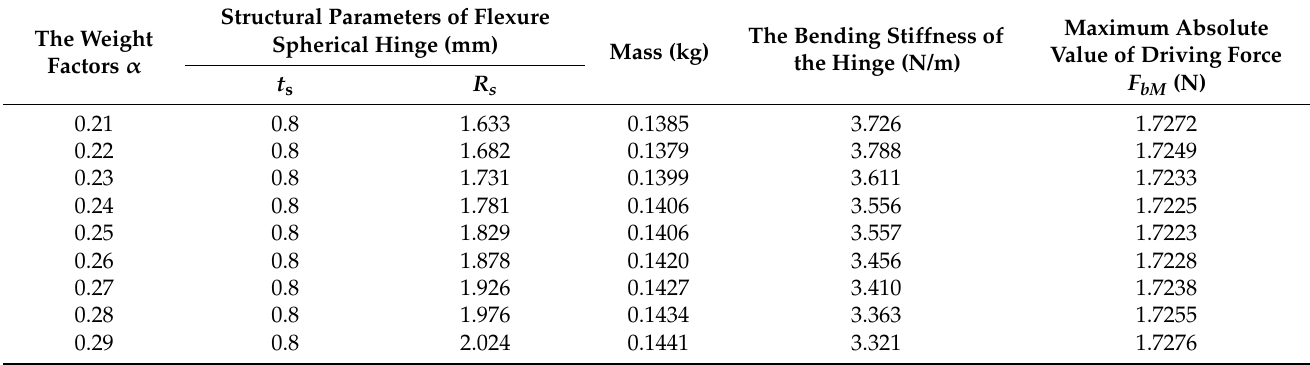
compared to the cutting radius R s . Table 3. Optimization results with the weight factors varying from 0.21 to 0.29.